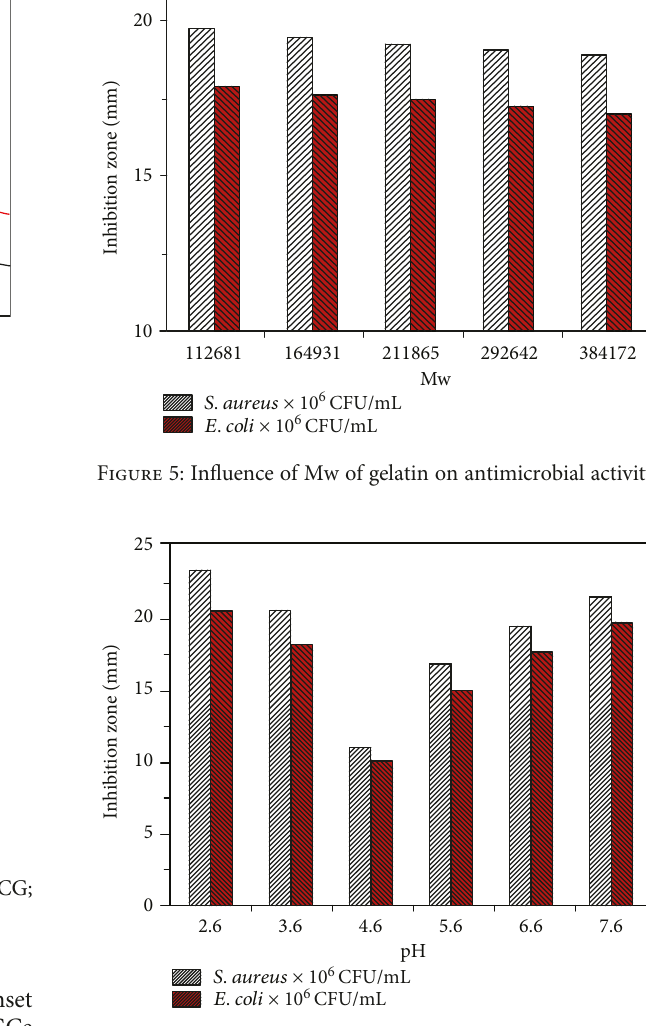
Figure 6: In fl uence of pH on antimicrobial